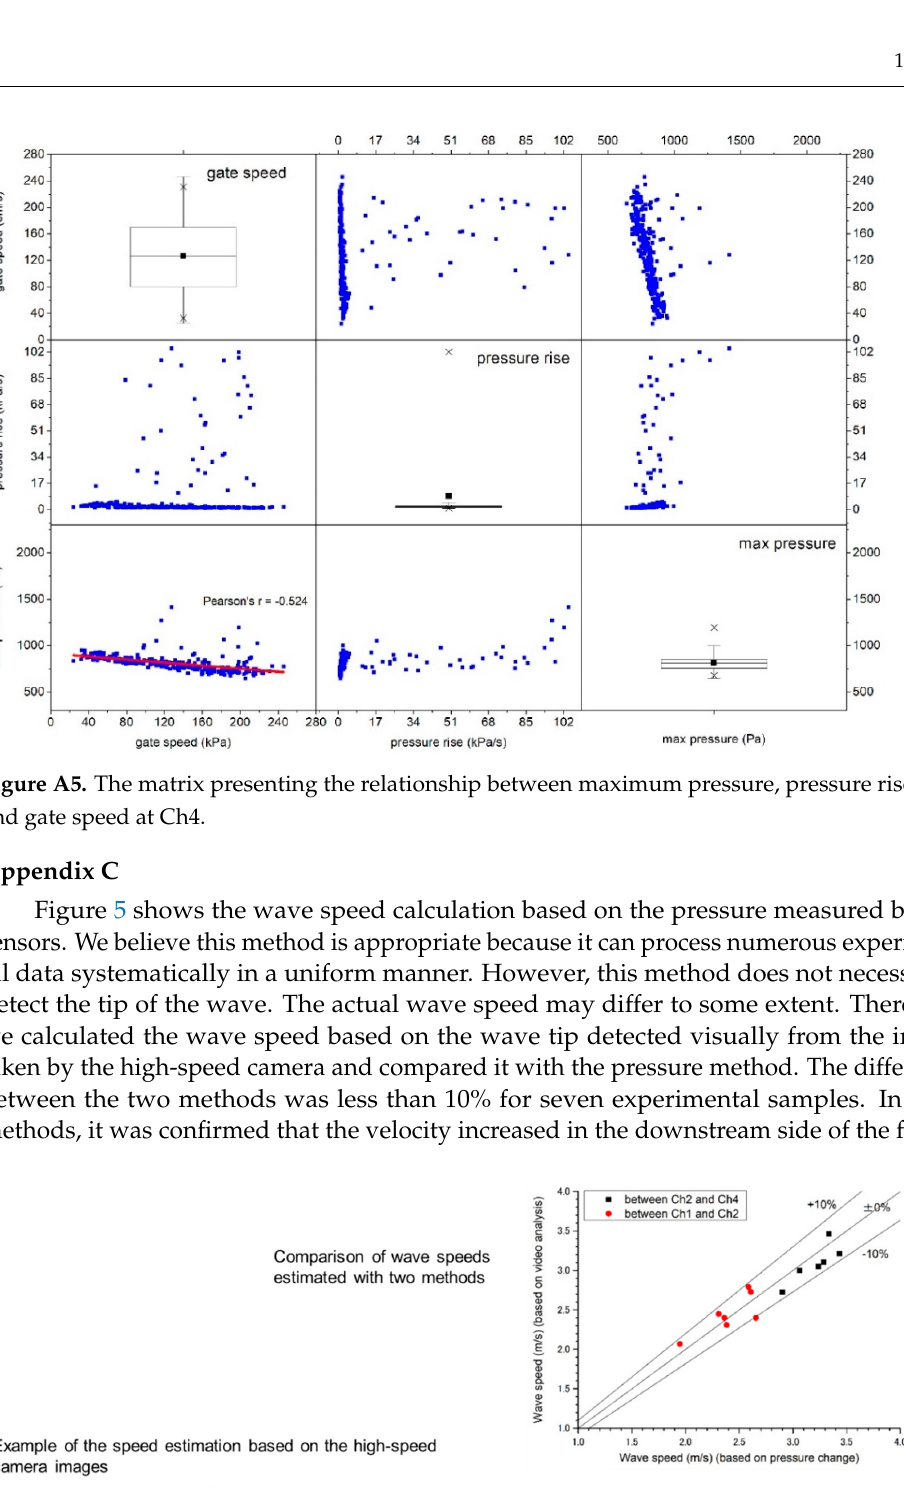
Figure A3. The matrix presenting the relationship between maximum pressure, pressure rise rate, and gate speed at Ch3.